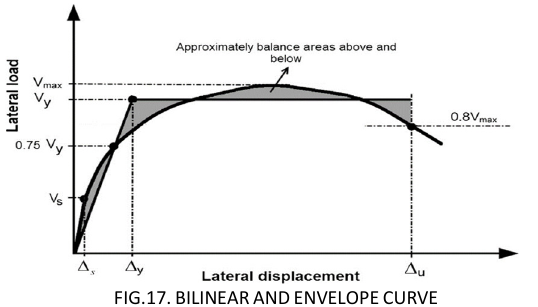
FIG.17. BILINEAR AND ENVELOPE CURVE